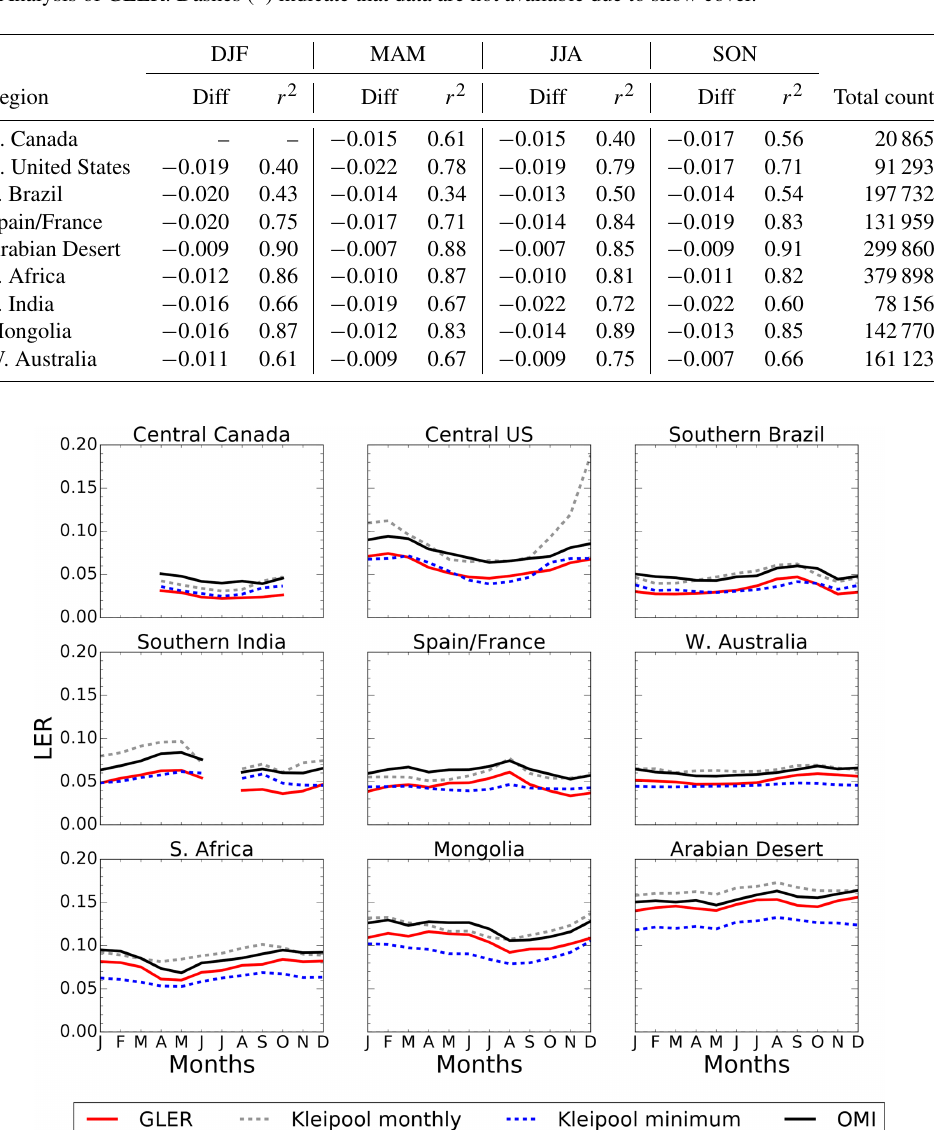
Table 3. Seasonal Analysis of GLER. Dashes (–) indicate that data are not available due to snow cover.